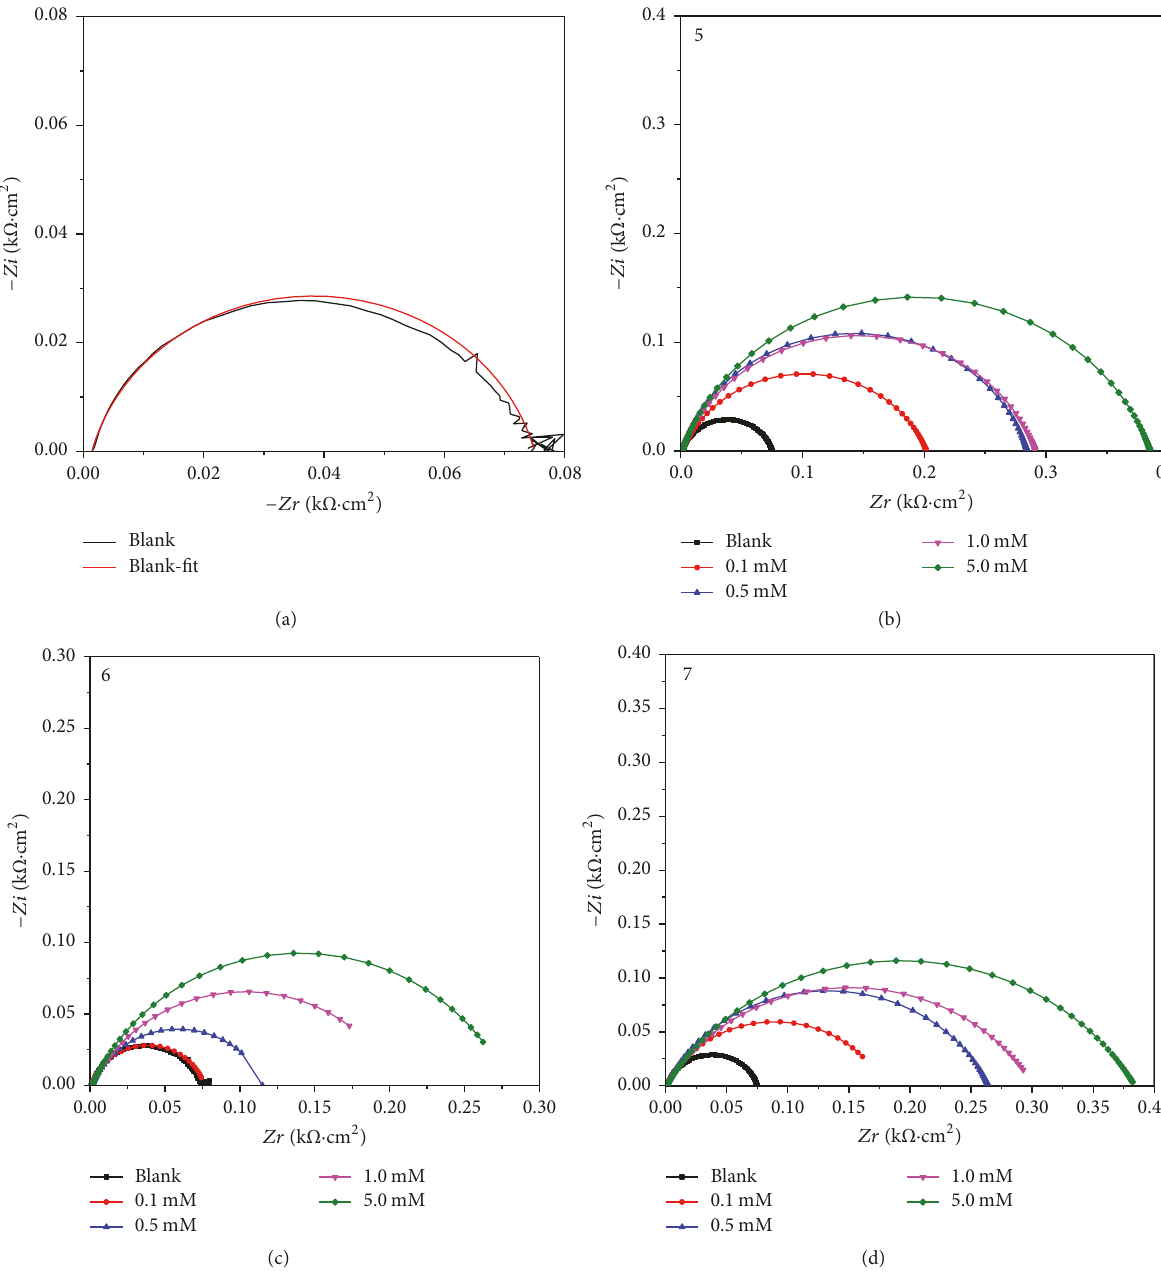
Figure 3: Nyquist plots of steel (a) in 1MHCl (b) with different concentrations of Camphor thiosemicarbazone (c), with different concentrations of Carvone thiosemicarbazone (d), and with different concentrations of Pulegone thiosemicarbazone at 293